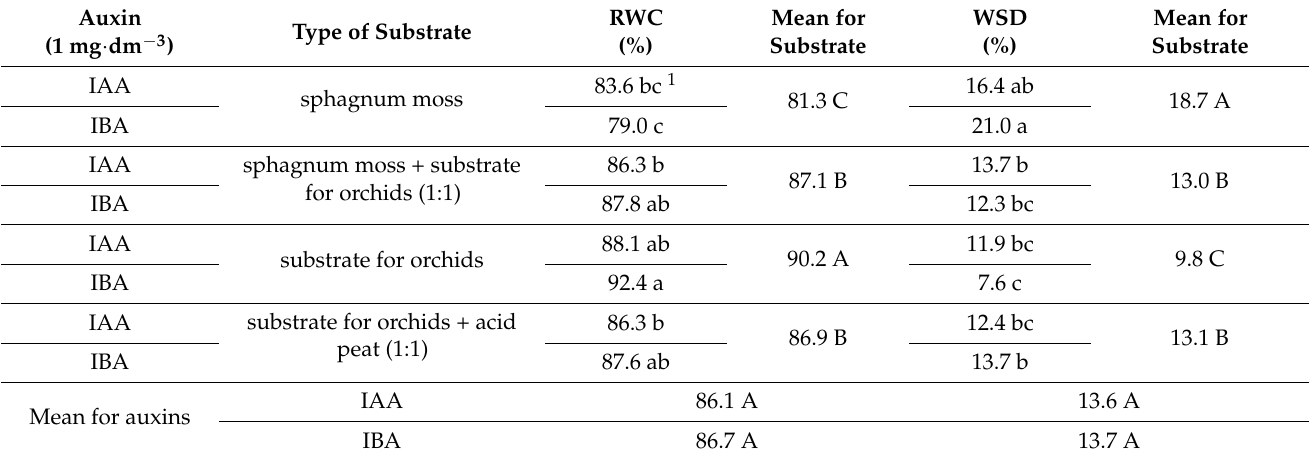
Table 7. A subsequent effect of IAA or IBA used in vitro and substrate type on relative water content (RWC) and water saturation deficit (WSD) in leaves of Paphiopedilum insigne.